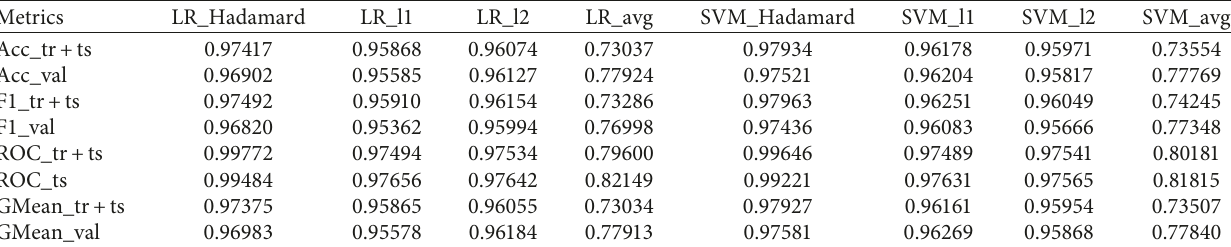
Table 9: For retweeting interaction from May 21 until May 26 in 2021, utilizing the obtained embeddings through Node2Vec, performance of the LR and SVM models with operators Hadamard, l1, l2, and average 1,2 . Metrics